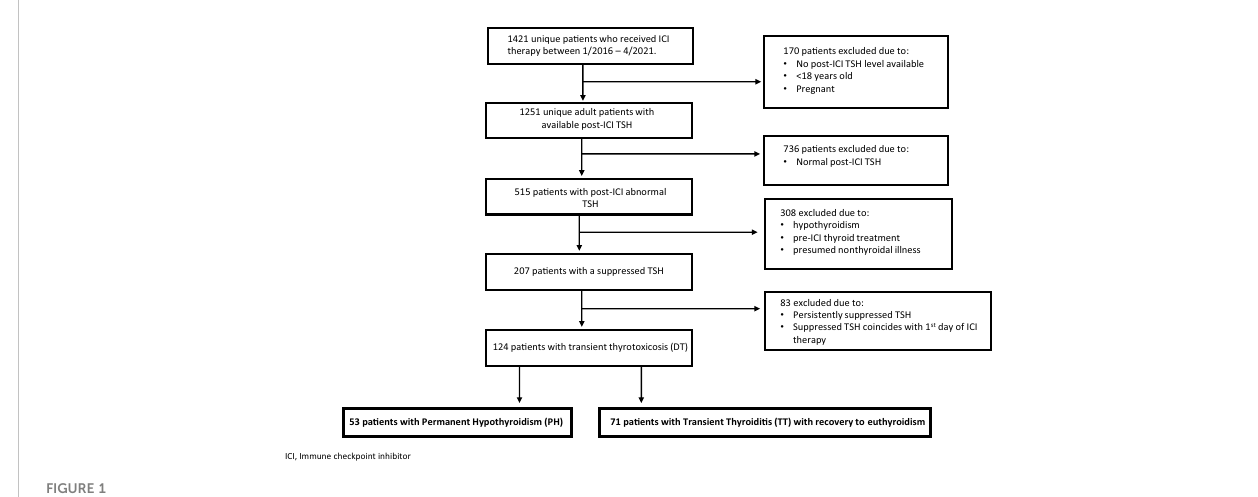
FIGURE 1 Consort Flow Diagram. ICI, immune checkpoint inhibitor; DT, destructive